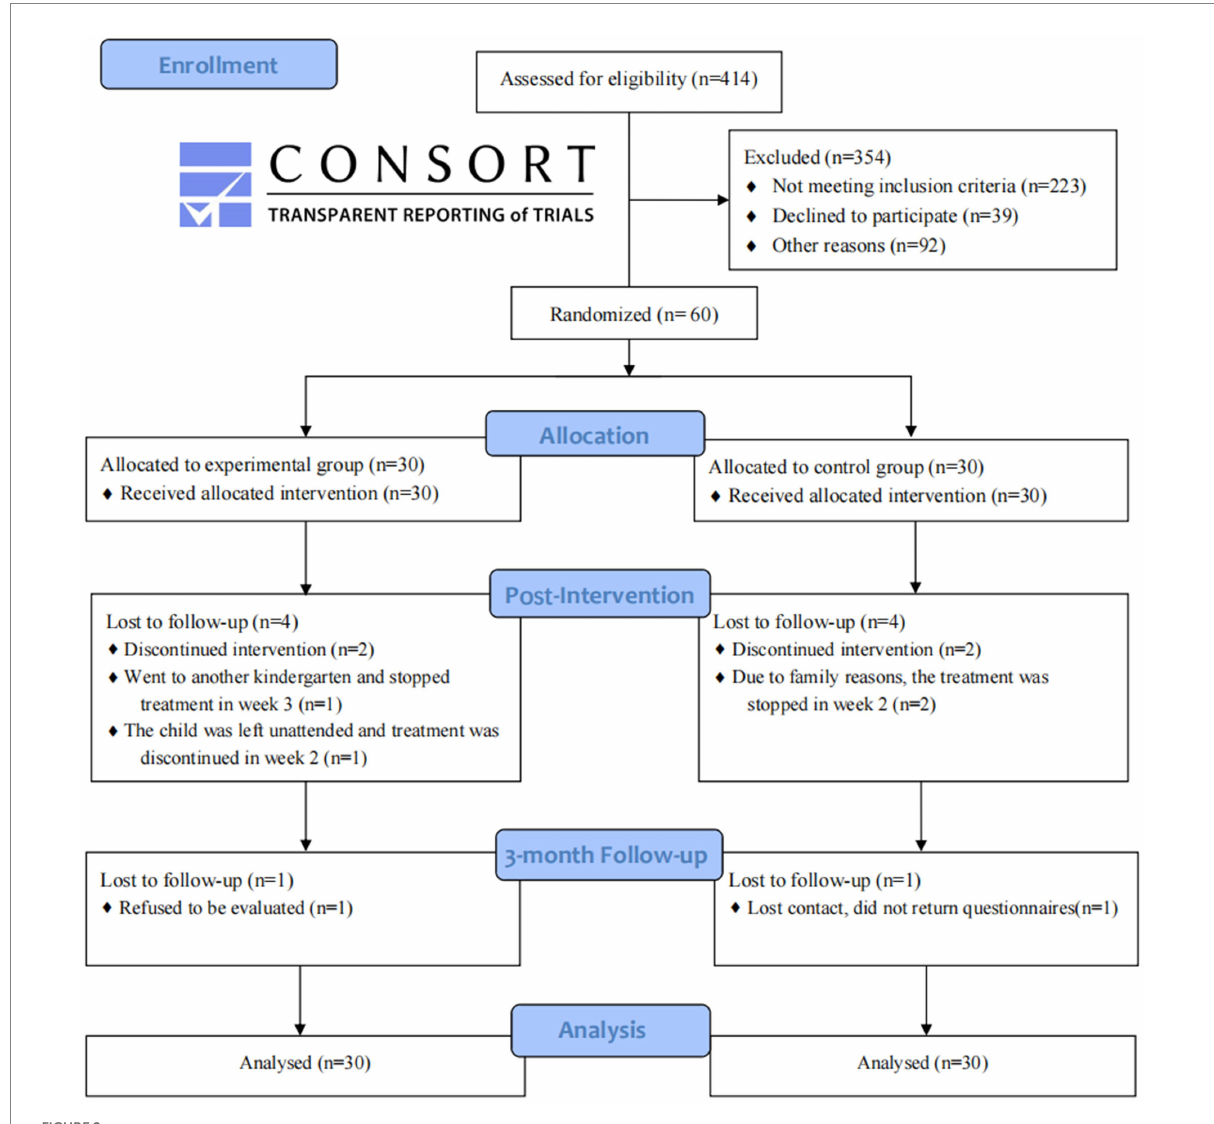
FIGURE 2 CCT study protocol and participant flow according to Consolidated Standards of Reporting Trials (CONSORT)